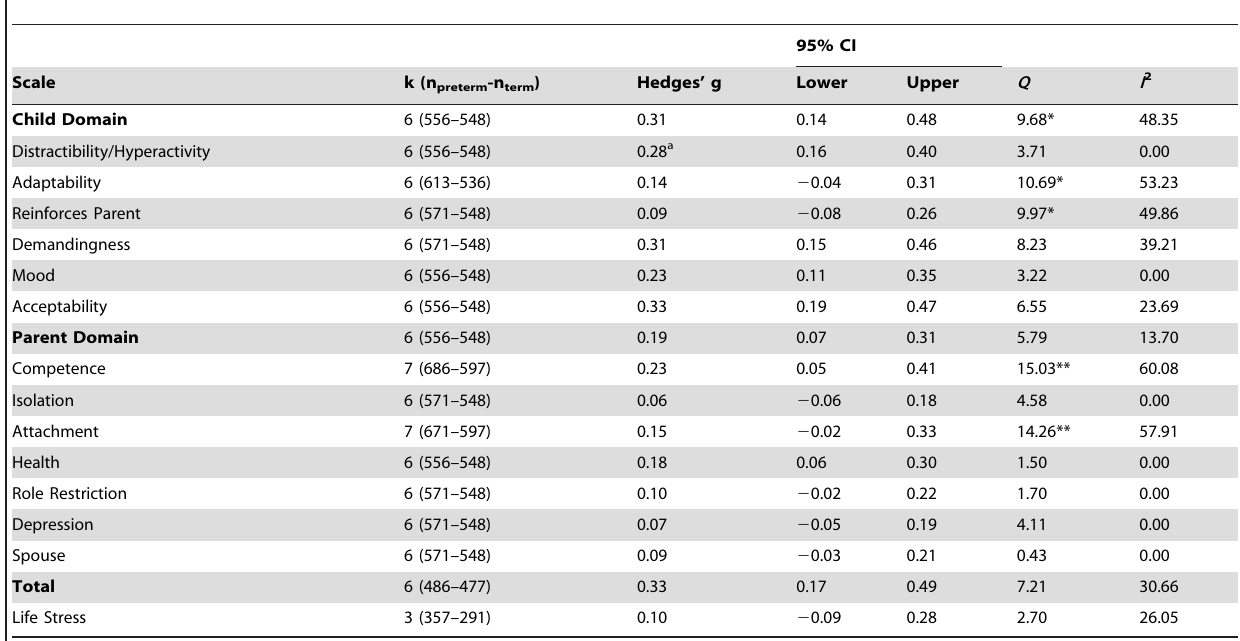
Table 6. Meta-Analytic Results of Standardized Differences in PSI Scores Between Parents of Preterm-Born and Term-Born Children.